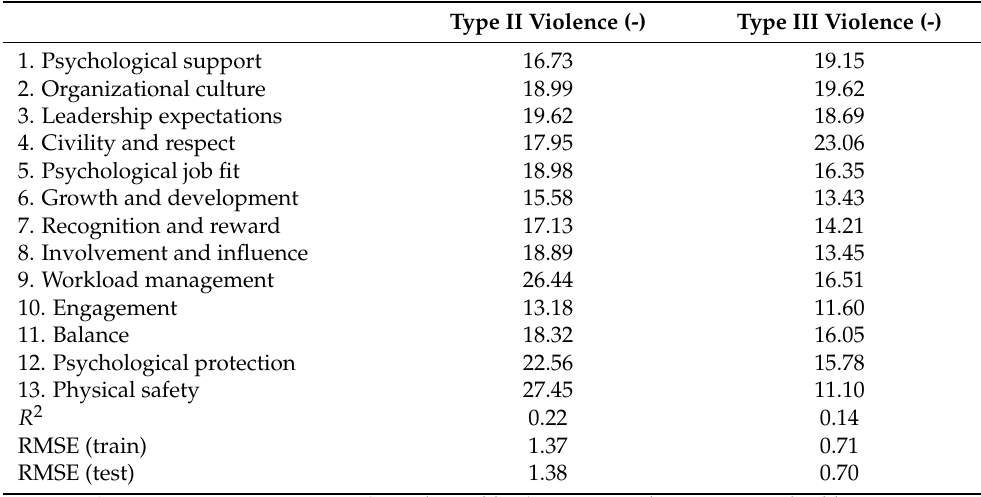
Table 3. Workplace conditions regressed on two workplace violence outcomes using random forest regression